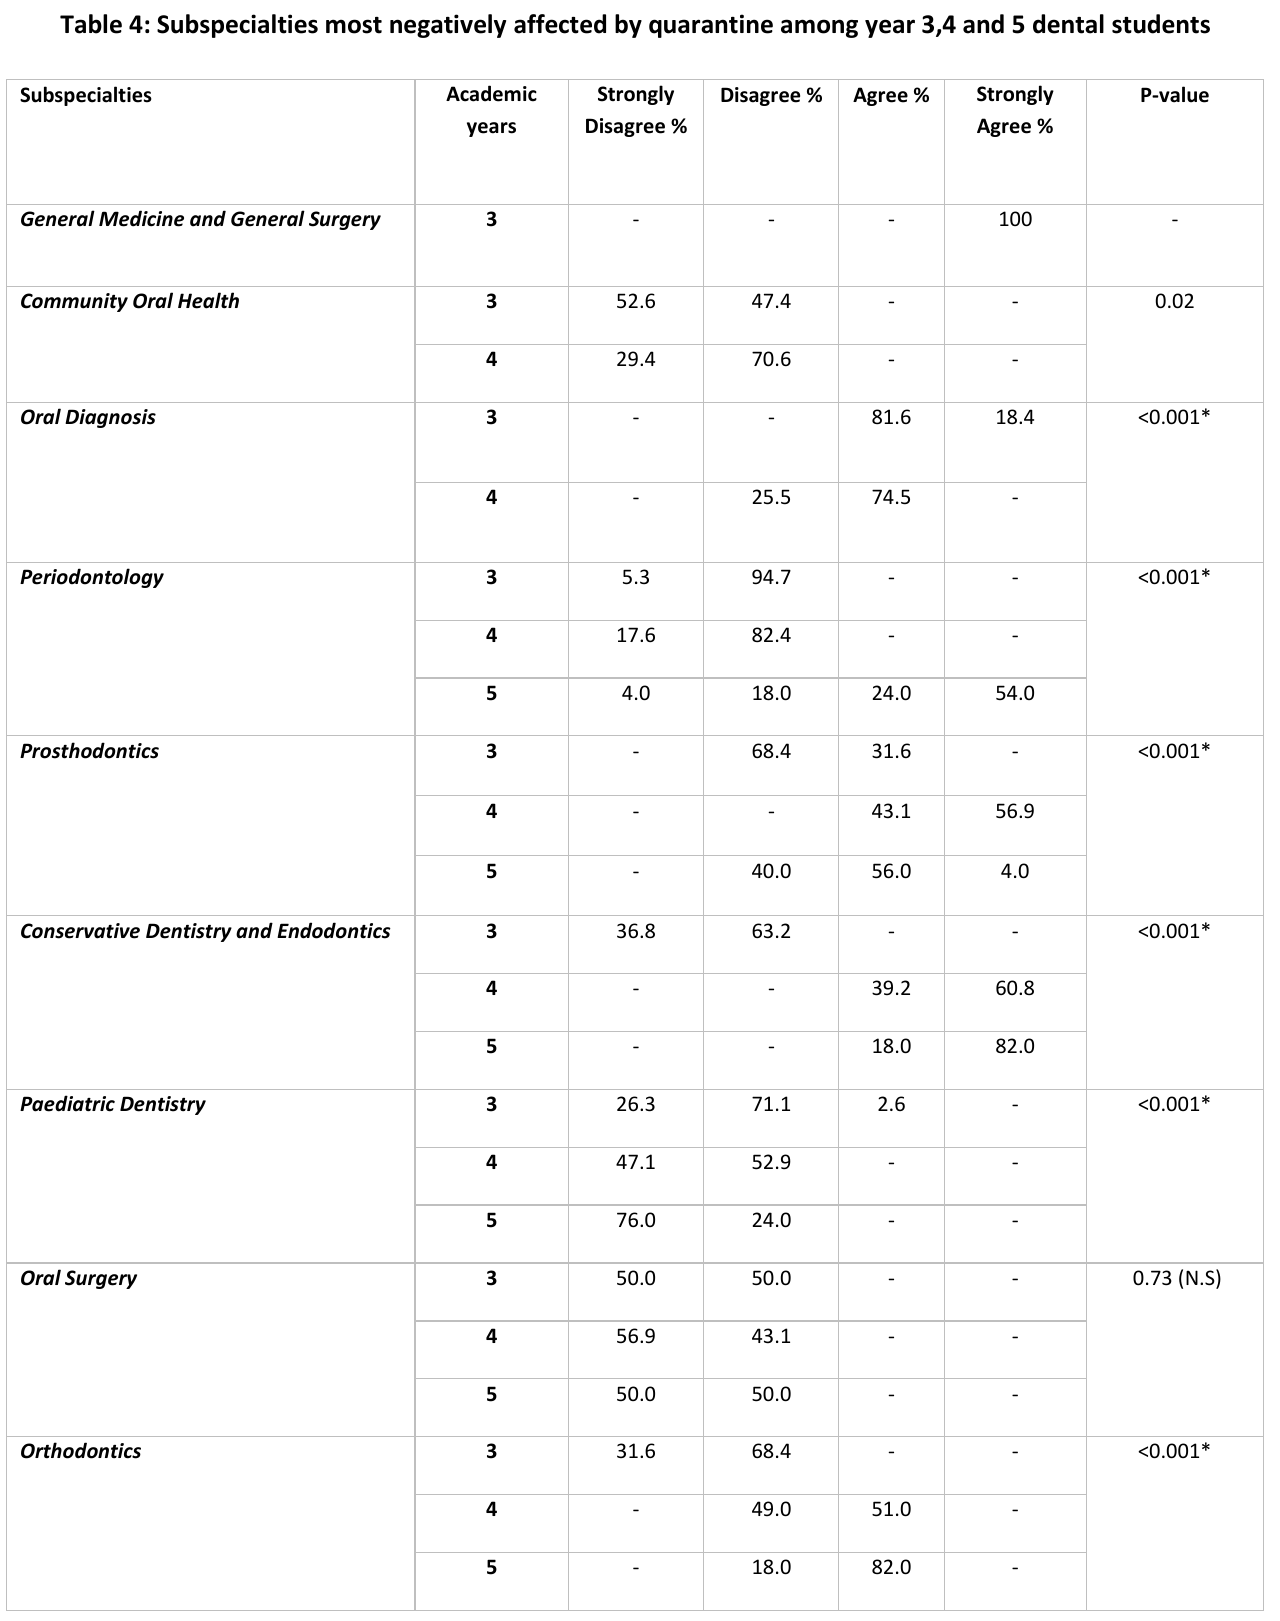
Table 4: Subspecialties most negatively affected by quarantine among year 3,4 and 5 dental students Subspecialties Academic